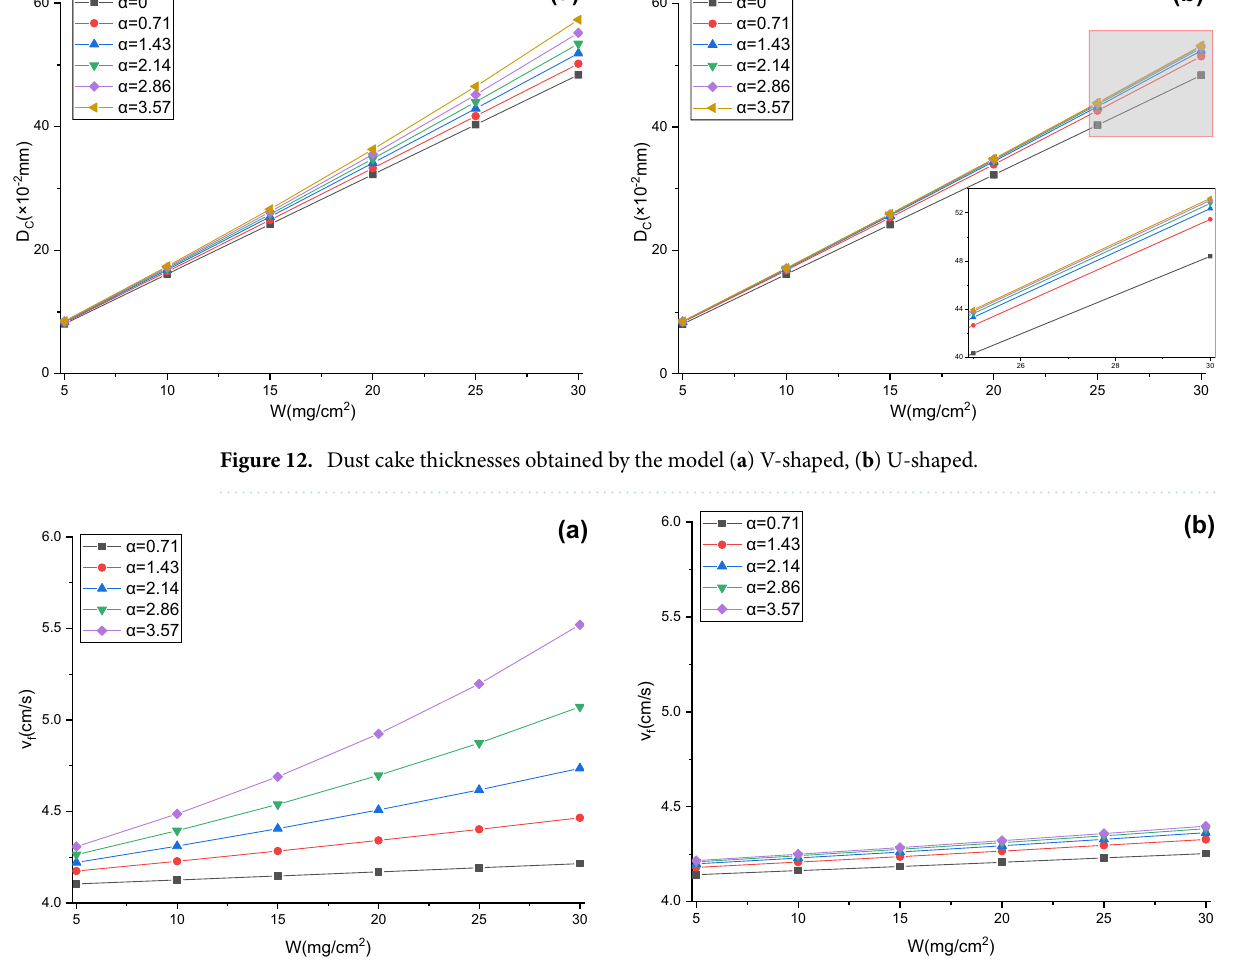
Figure 13. Effective filtration velocities obtained by the model ( a ) V-shaped, ( b )